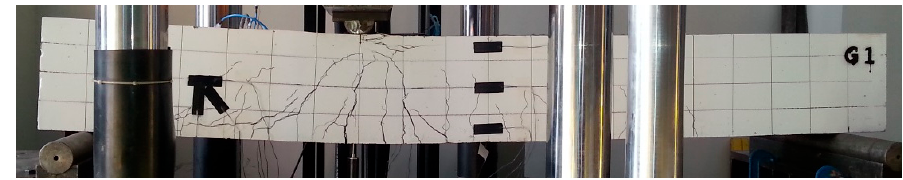
Figure 15. Crack pattern (G).